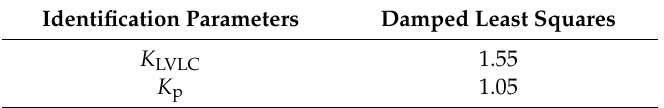
Figure 14. Active power fitted curve of large disturbance of grid voltage.